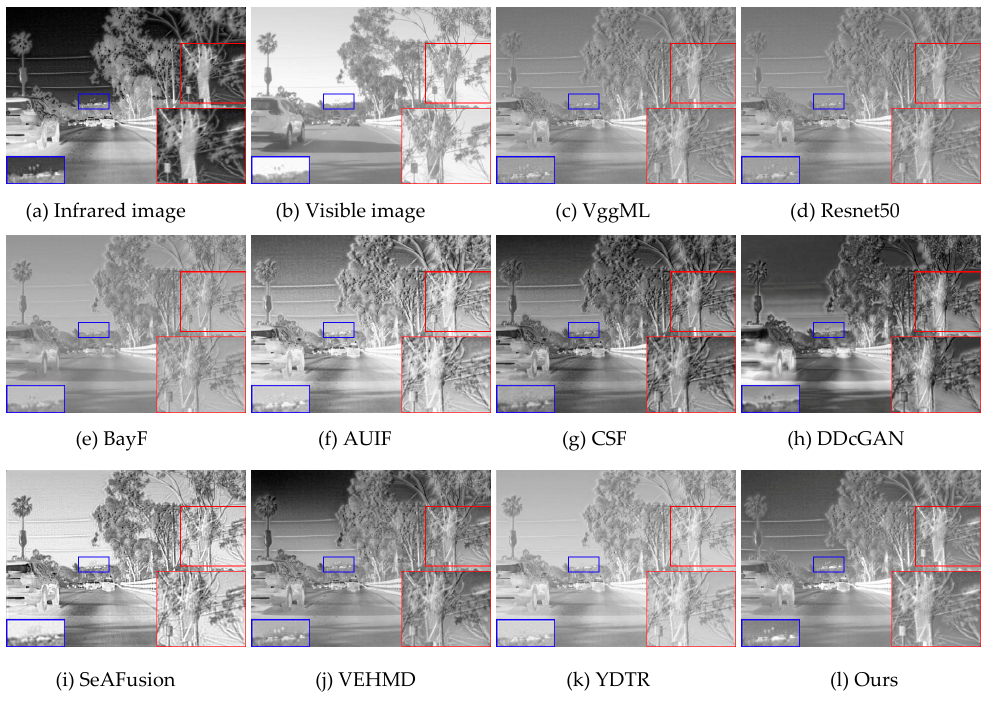
Figure 4. Fused images using ten different methods when the source image is